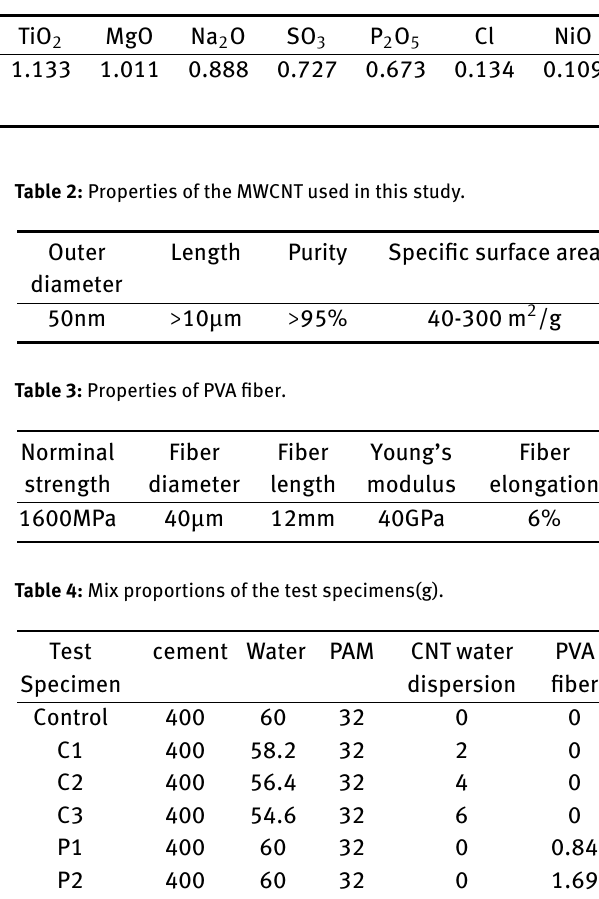
Table 1: Chemical composition of the cement.